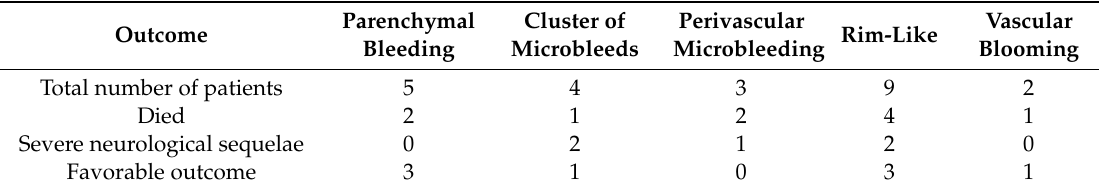
Table 3. T2*, SWI findings and outcome.